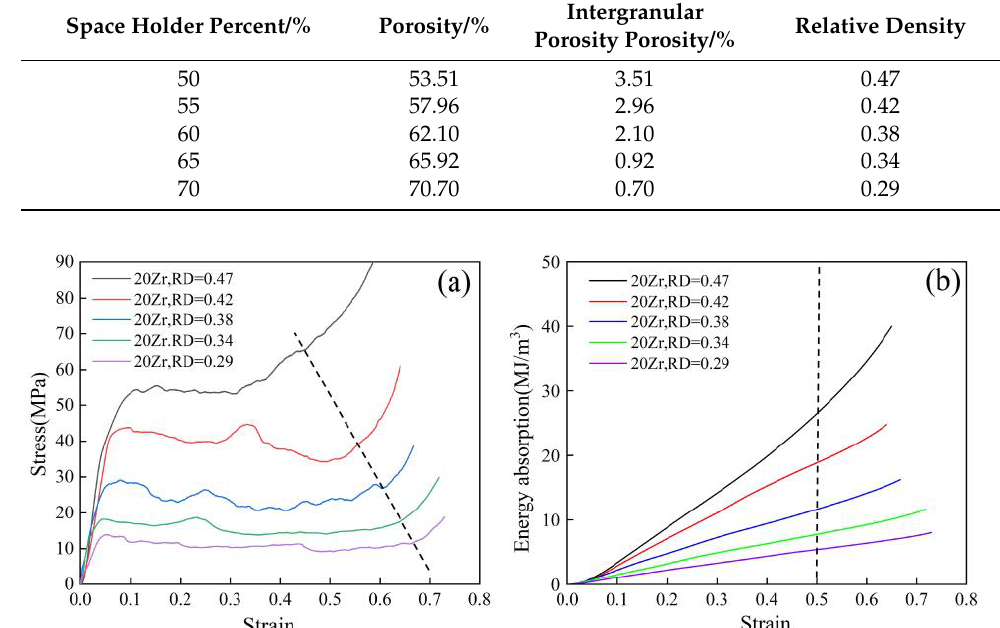
Figure 12. ( a ) Compressive stress – strain and ( b ) energy absorption capacity curves of composite materials with different relative densities.